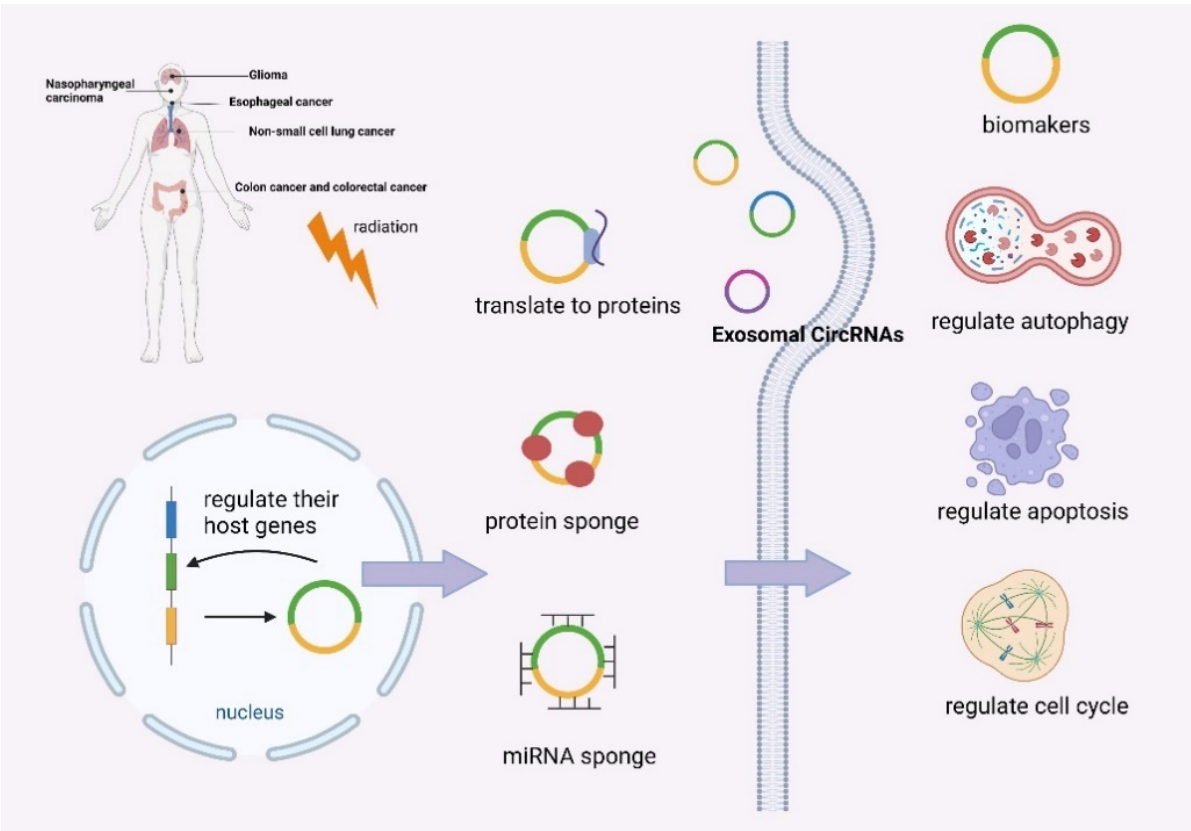
Figure 2. The mechanism of circRNA in tumor radioresistance.